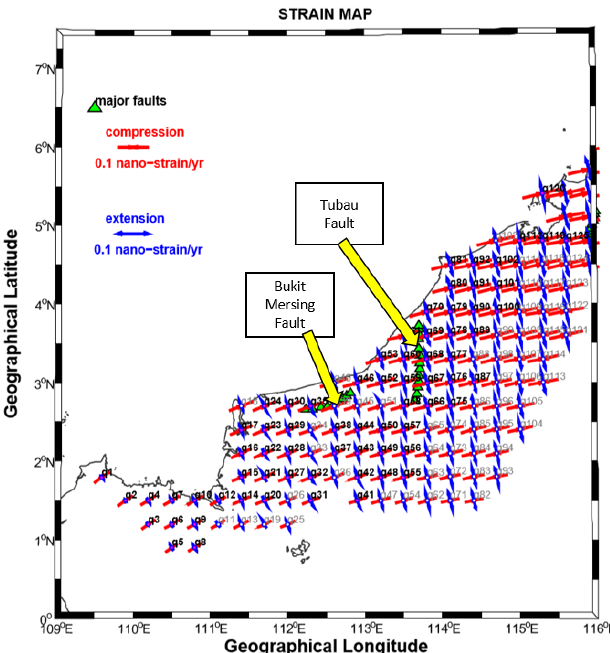
Figure 14. Strain rate map over Sarawak in